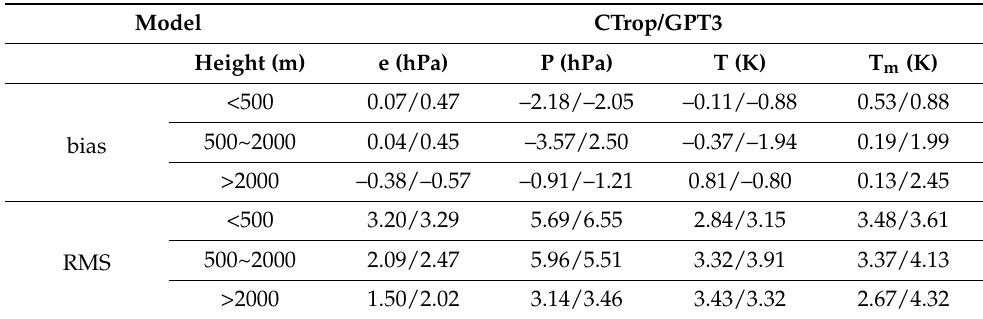
Figure 10. Distribution of the performance of temperature at each radiosonde site in 2017 by the CTrop and GPT3 models: ( a ) Bias of GPT3; ( b ) Bias of CTrop; ( c ) RMS of GPT3; ( d ) RMS of CTrop. The height of the radiosonde site is divided into three bands, and the performance at different heights of the CTrop and GPT3 models are calculated. The results are listed in Table 2. The precision of the two models is related to height. With the increase in height, the performance of pressure and water vapor pressure is improved, but the temperature height, which is contrary to that of the GPT3 model. Table 2. Statistics of performance at different heights of the CTrop and GPT3 models validated by radiosonde data.